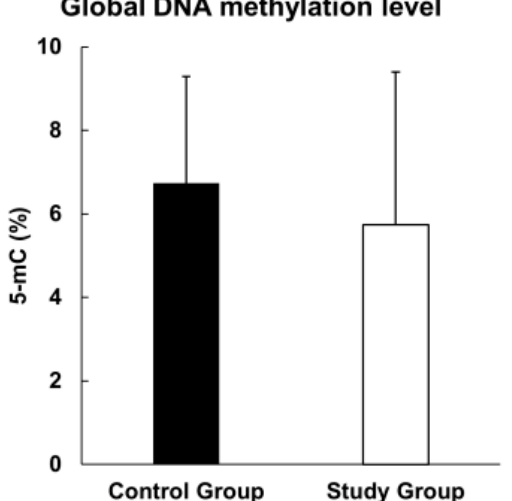
Figure 1. Global methylation level in study and control groups.